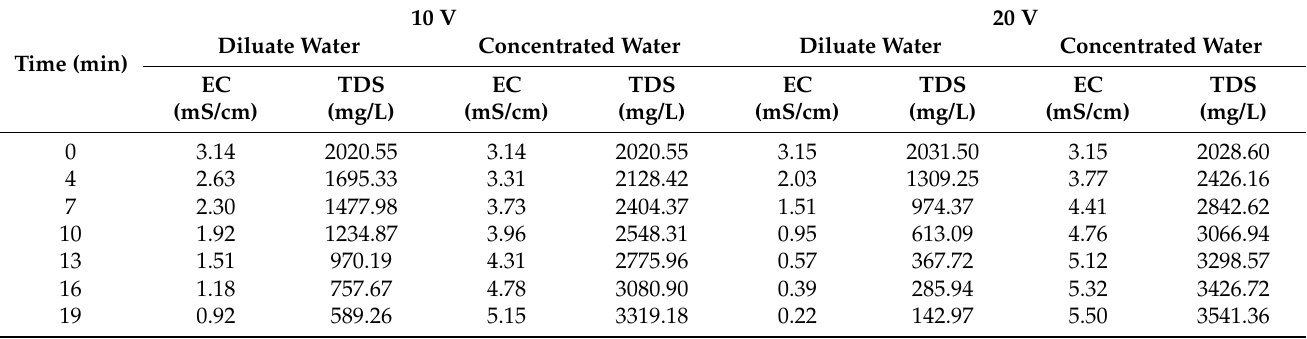
Table A1. Desalination results for the 2000 mg/L TDS sample at 25 ◦